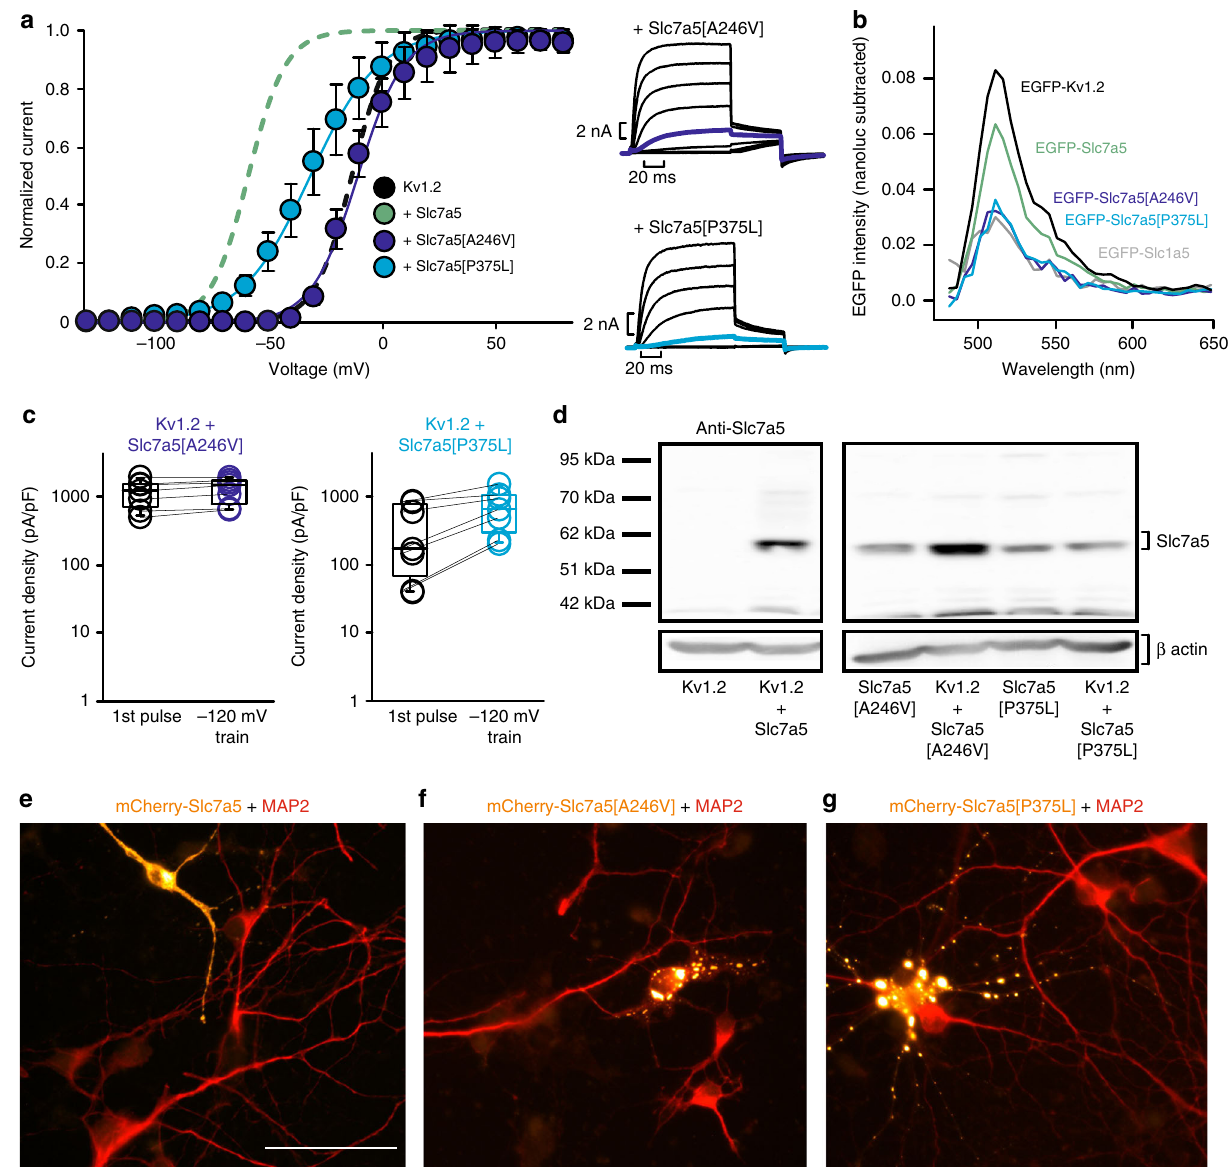
Fig. 8 Disease-linked Slc7a5 mutations have attenuated effects on Kv1.2. a Kv1.2 channels were co-expressed with Slc7a5[A246V] or Slc7a5[P375L] (1:1) in ltk- mouse fi broblast cells. Conductance-voltage relationships were gathered as described in Fig. 1 ( + Slc7a5[A246V] V 1/2 = − 10 ± 6 mV, k = 11 ± 3 mV, n = 6; + Slc7a5[P375L] V = − 32 ± 8 mV, k = 16 ± 8 mV, n = 10). Dashed lines illustrate conductance-voltage relationships for WT Kv1.2 (black) and 1/2 Slc7a5 (green) as a reference. b Representative BRET signals were calculated for mEGFP-tagged Slc7a5 mutants co-expressed with Kv1.2-nanoluc, as described in Fig. 6 (representative data from three experiments). c Current density at + 60 mV was measured from Kv1.2 co-expressed with various Slc7a5 mutants, before and after a 30 s train of − 120 mV hyperpolarizations to − 120 mV. d Cell lysates were probed for Slc7a5 expression using western blot for cells transfected with Kv1.2 plus each of the Slc7a5 mutations. No signi fi cant changes were detected for expression of the Slc7a5 mutants ( n = 3, p > 0.05).